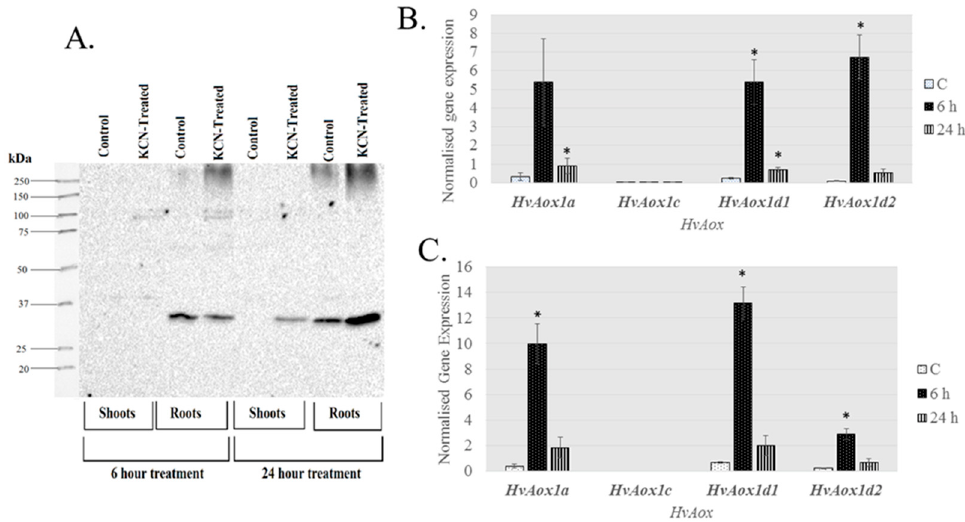
Figure 6. Chemical treatment increases AOX protein levels in barley shoot and root tissue. Barley seedlings (14 days old) were exposed to 5 mM potassium cyanide (KCN) for up to 24 h, then root and shoot tissue were used for crude protein extractions. ( A ) Immunoblot of crude protein extracts under reduction conditions. The expected size for HvAOX is 35–37 kDa. Expression levels of AOX isoforms were determined using qRT-PCR in shoots ( B ) and roots ( C ). Expression data were normalized with reference genes Actin , Ubiquitin and Pdf (Protein phosphatase) and shown as mean of 4 biological replicates. Gene expression data were derived from the same experiment as presented in Table 3, but shown as normalised expression instead of fold-change, to demonstrate the relative level of expression between genes. * denotes significantly different ( p < 0.01) from the control ( C ).